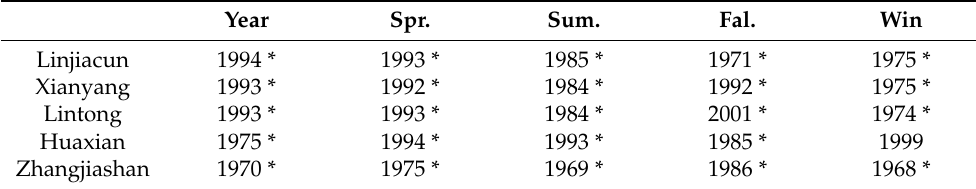
Table 10. CPBI trend test at Huaxian station of Weihe. Year Spr.